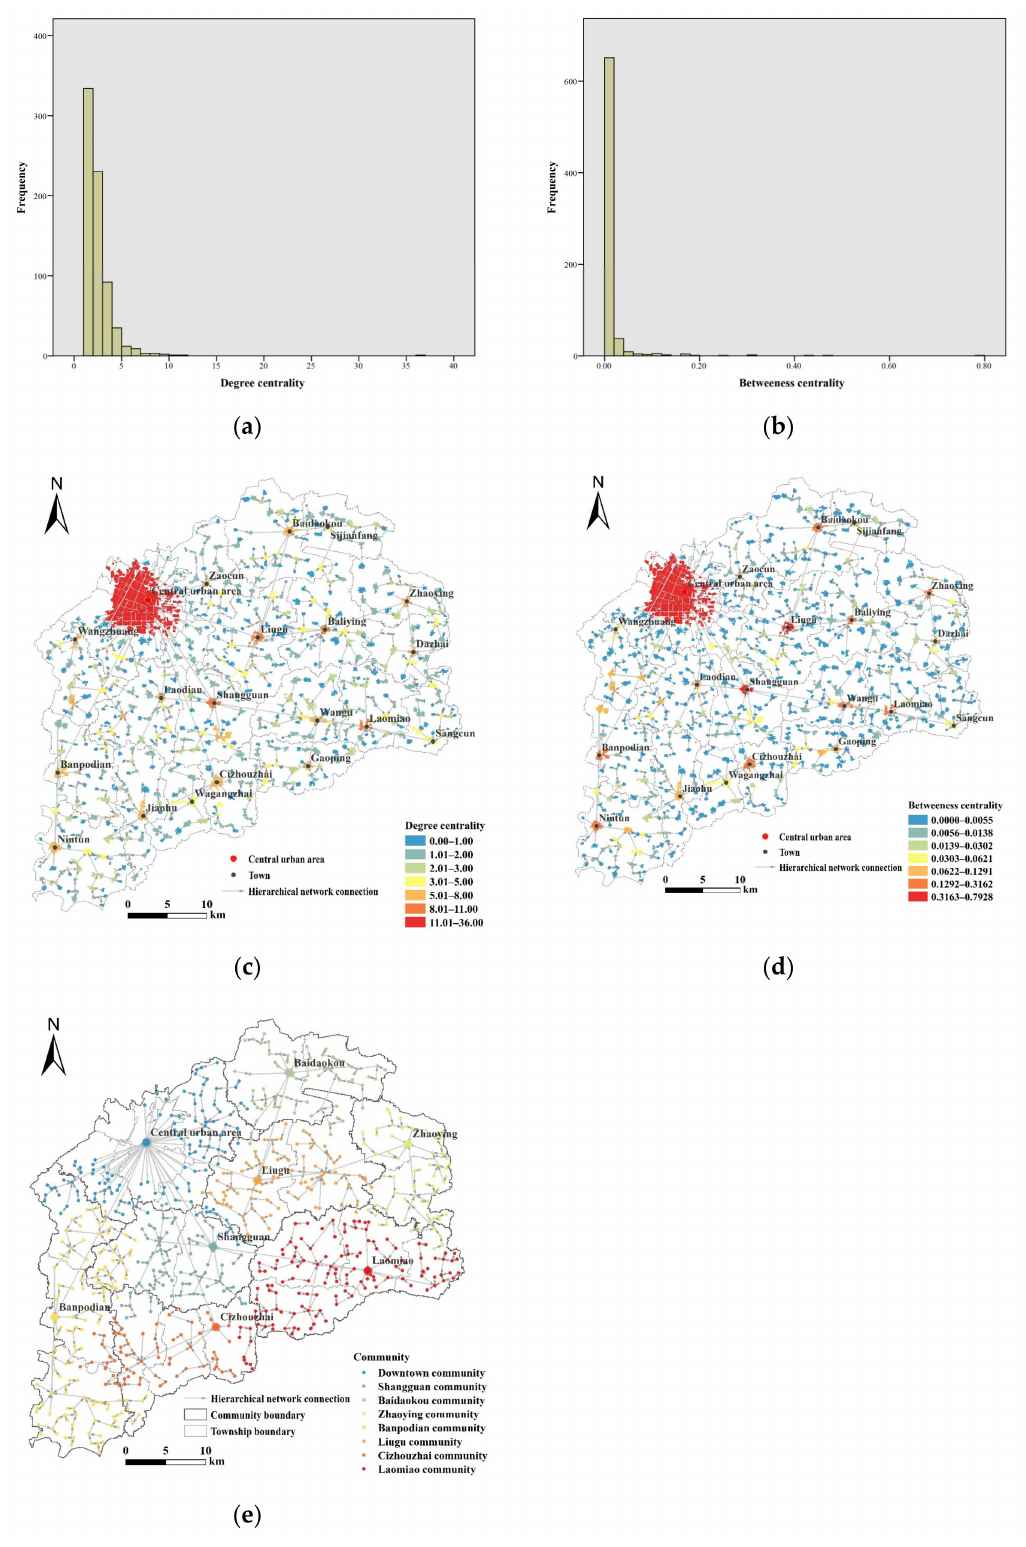
Figure 6. Network analysis of the hierarchical network structure of urban and rural settlements in Hua County: ( a ) Frequency distribution of degree centrality; ( b ) Frequency distribution of betweenness centrality; ( c ) Spatial distri- bution of degree centrality; ( d ) Spatial distribution of betweenness centrality; ( e ) Community